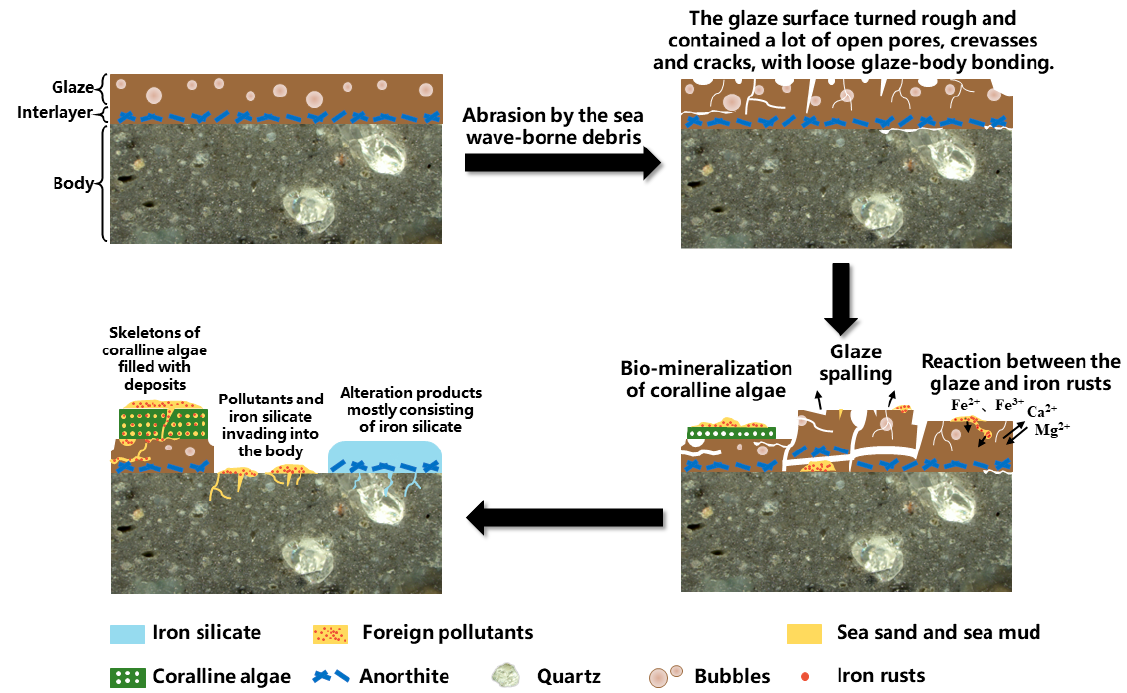
Figure 16. Illustration of the degradation process of the sauce-glazed ware DL.